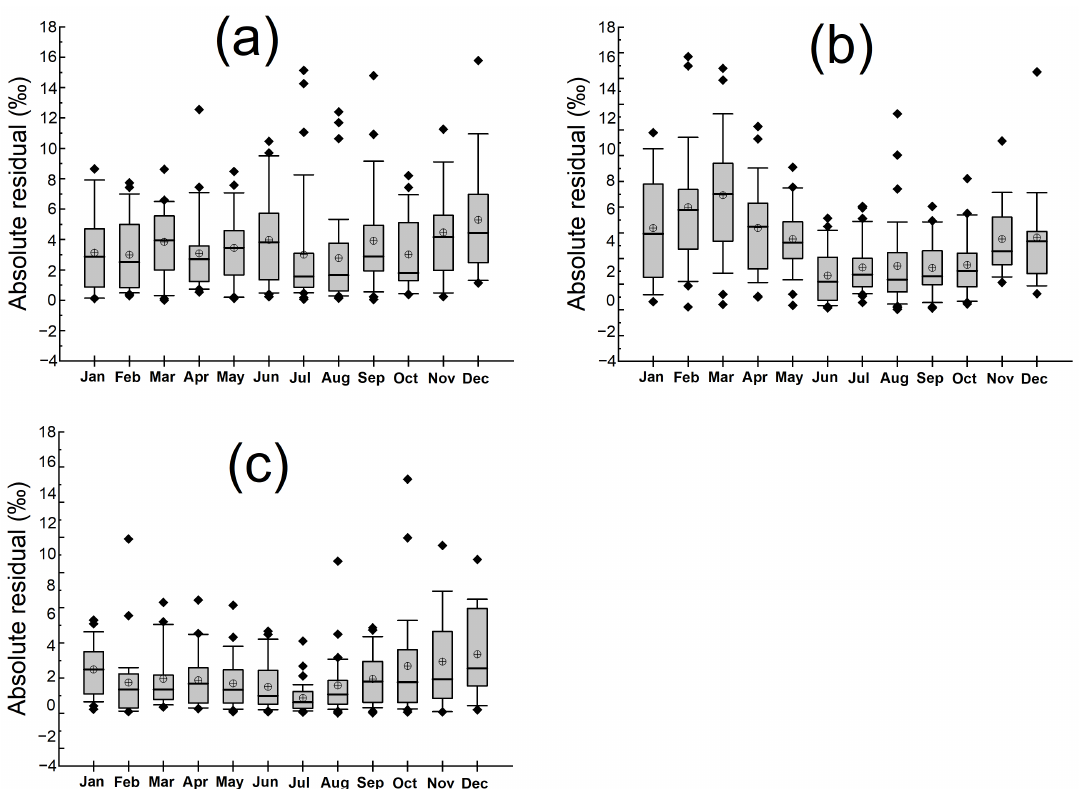
Figure 7. Box plots of the monthly distribution of absolute residuals between the three isoscapes and the observations at 32 stations: ( a ) OIPC, ( b ) RCWIP, and ( c ) this study. The boxes represent 25–75th percentiles, and the line through the box represents the median; the whiskers indicate the 90th and 10th percentiles; the rhombus above and below the whiskers indicates the outliers; and the circle with a cross in the center indicates the average